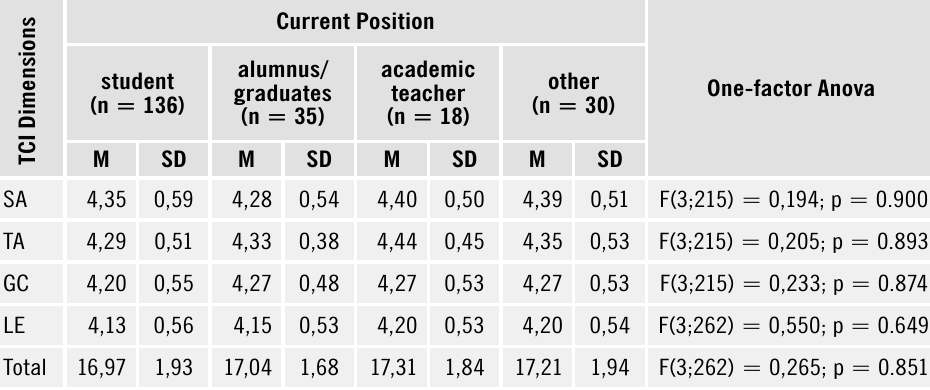
One-factor Anovastudent